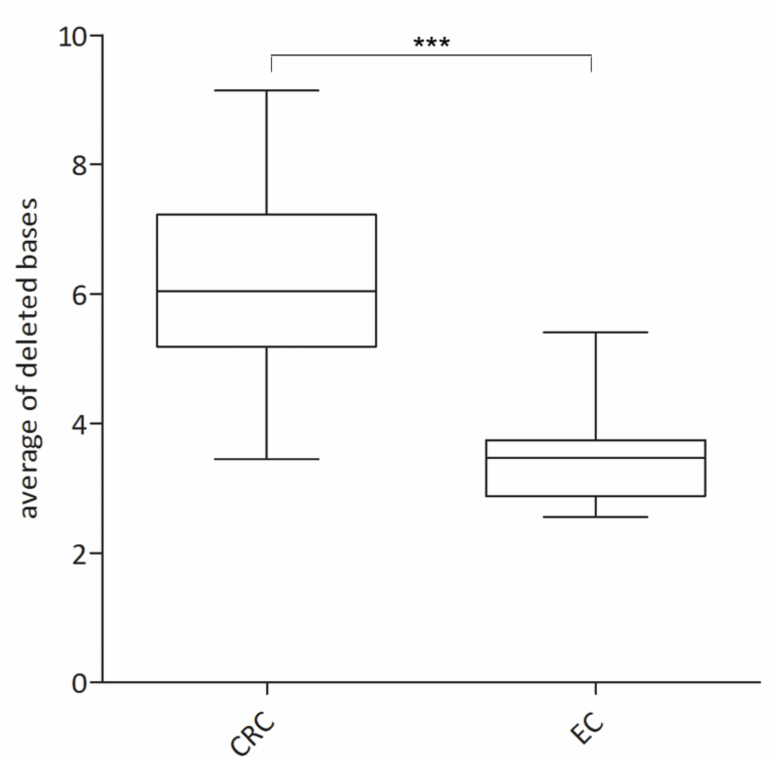
Figure 3. Statistical analysis of the average of deleted bases in colorectal cancer (CRC) and endome- trial cancer (EC). Box plot graph was obtained via the GraphPad Prism software and p -value was calculated using the unpaired t -test with a significance level of p < 0.05. Statistical analysis revealed a significant divergence of the average of deleted bases between CRC and EC ( p -value ≤ 0.0001). Level of significance is indicated by ***